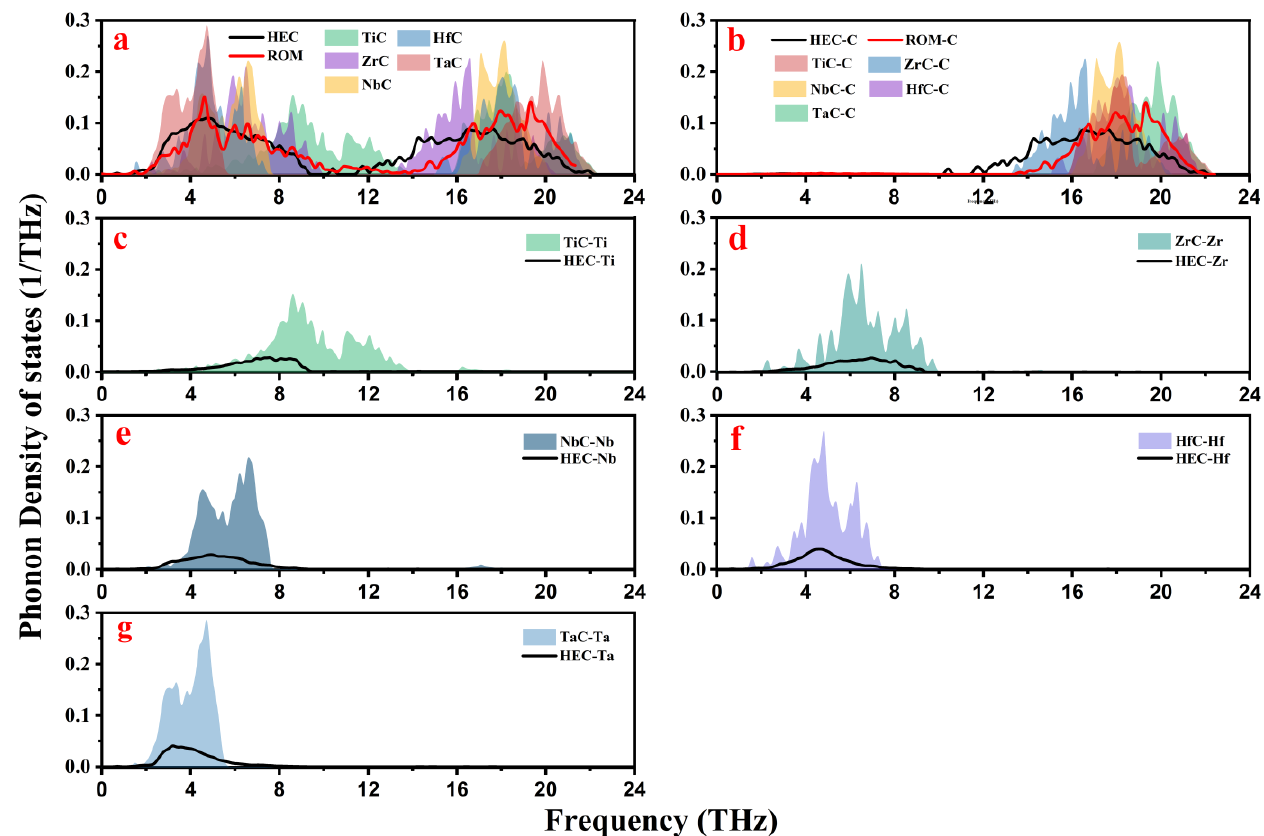
Figure 3. ( a ) Total phonon density of states of (Ti 0.2 Zr 0.2 Nb 0.2 Hf 0.2 Ta 0.2 )C and individual carbides (TiC, NbC, ZrC, TaC, HfC); ( b ) the partial phonon density of states of C atom in HEC and individual carbides; ( c – g ) the partial phonon density of states of metal atom in HEC and individual carbides.